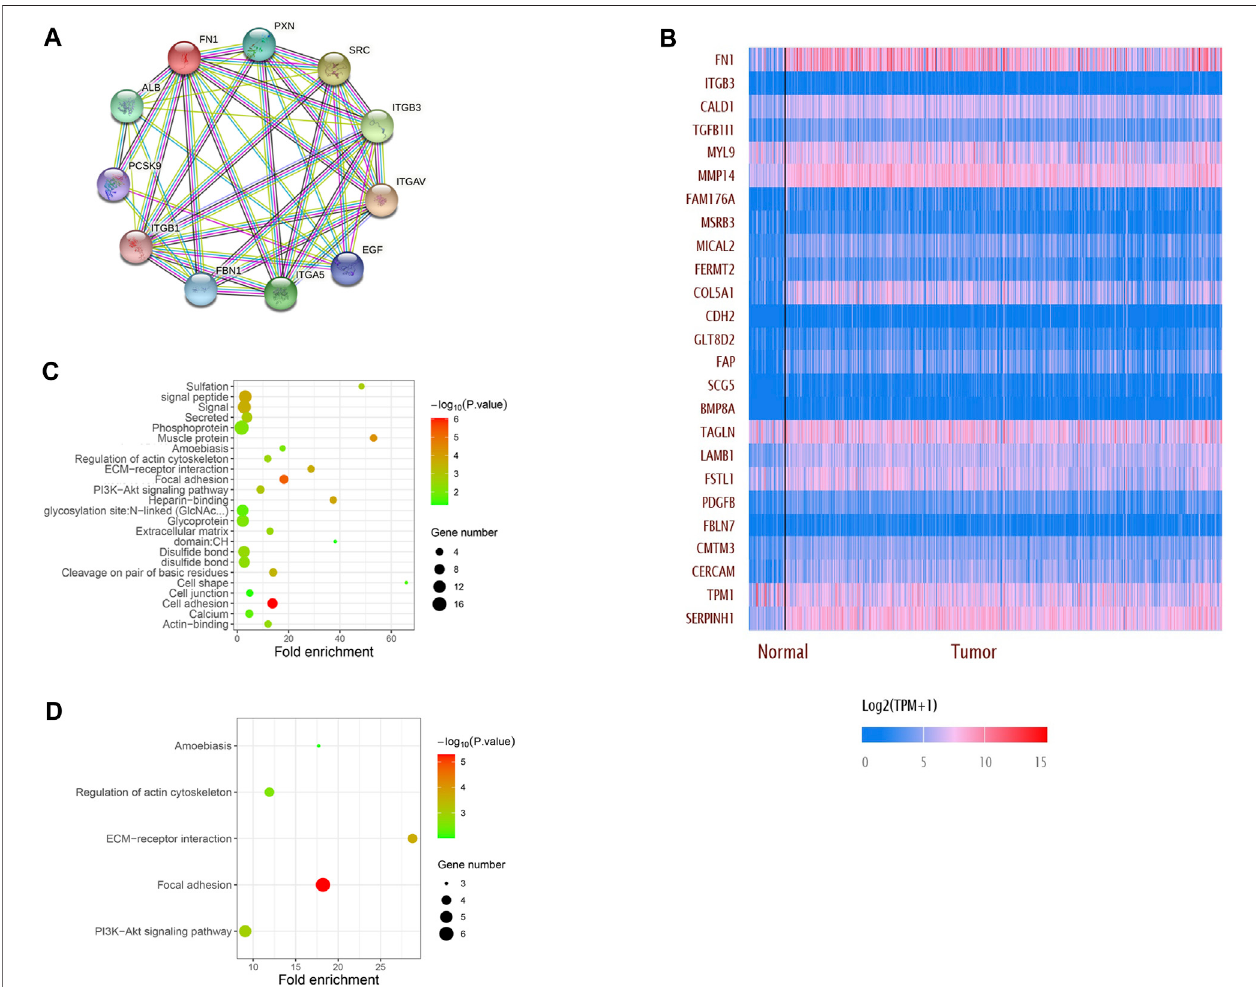
FIGURE 5 | Network establishment for FN1-correlated genes in HNSCC. (A) PPI networks of FN1 interaction partners generated using STRING and Cytoscape. (B) Top 25 genes positively or negatively correlated with FN1 were shown in the heatmap. Major biological processes, cellular components, molecular functions and signaling pathways of FN1 biology by GO enrichment (C) and KEGG pathway analysis (D)